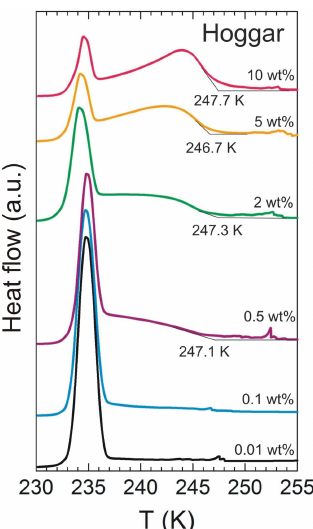
Fig. 6. DSC thermograms of a dust sample from Hoggar maun- tains. Curves are shown with different offsets for clarity. Suspension concentrations and onsets of heterogeneous freezing are indicated above and below the curves, respectively. The onset of the freezing peaks ( T on ) is given by the intersection of the two tangent lines (thin black curves) for each curve.